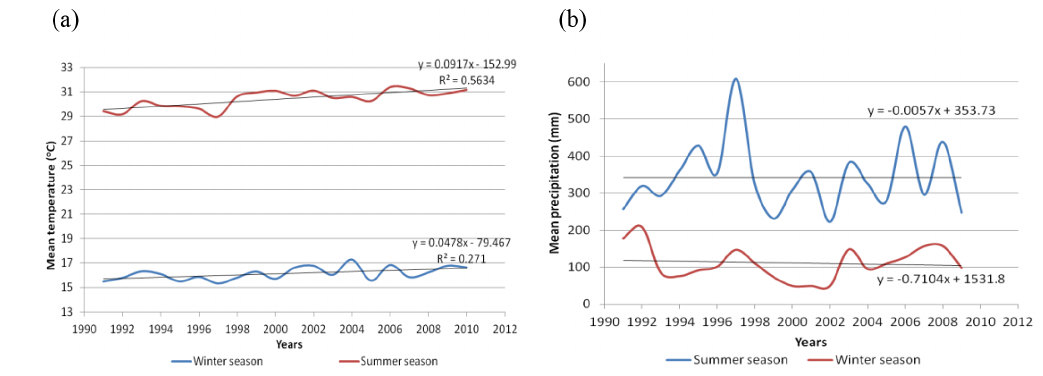
Figure 3. Mean temperature (a) and precipitation (b) trends in study area over the period of 1990–2010.